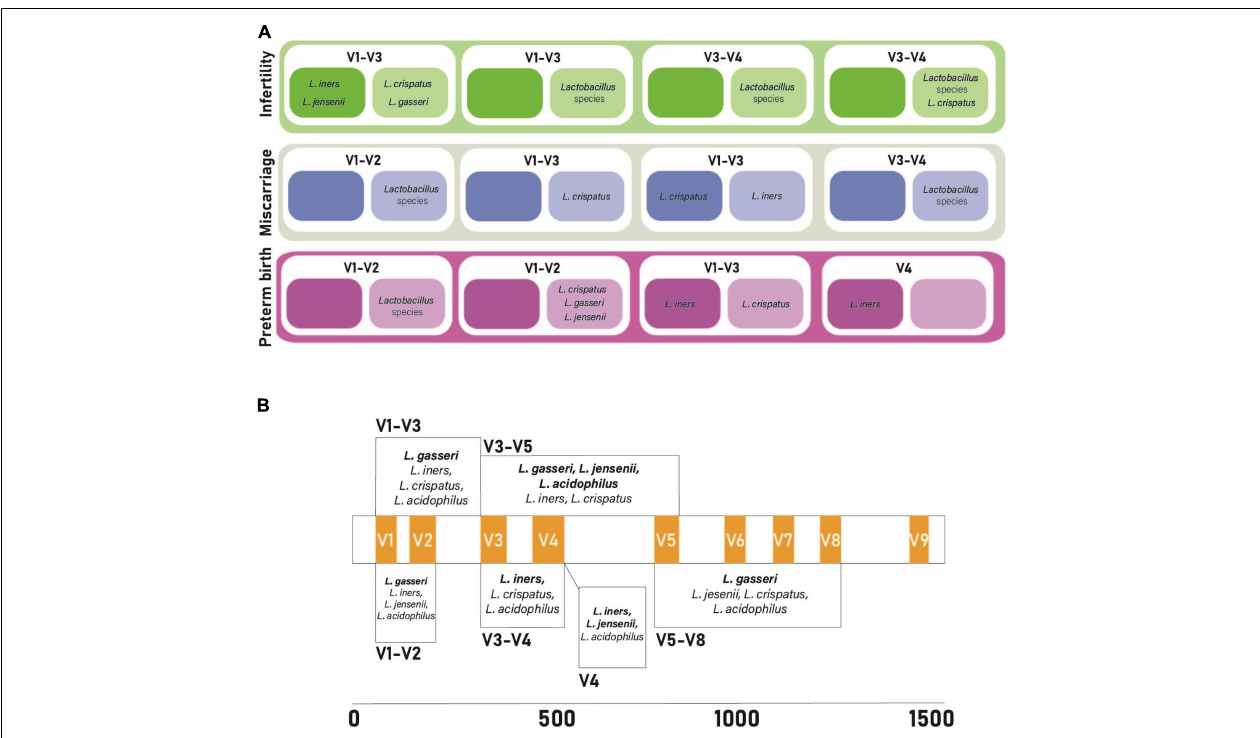
FIGURE 4 | Comparison of primer bias and findings from previously published vaginal microbiome studies investigating miscarriage, infertility, and preterm birth. (A) 16S rRNA primer pairs amplifying vaginal lactobacilli. Darker colored boxes represent increased abundance of lactobacilli, lighter colored boxes represent decreased abundance of lactobacilli in cases of infertility, miscarriage, and pre-term birth. (B) Predictive bias of primer pairs along the 16S rRNA gene. Hypervariable regions appear in orange. Each box is the predictive bias of the primer pairs that it spans. Bolded bacterial species names correlate with under-reported lactobacilli abundance and non-bolded bacterial species names correlate with over-reported lactobacilli abundance. References for the data from studies included in this figure can be found in Supplementary Table 1